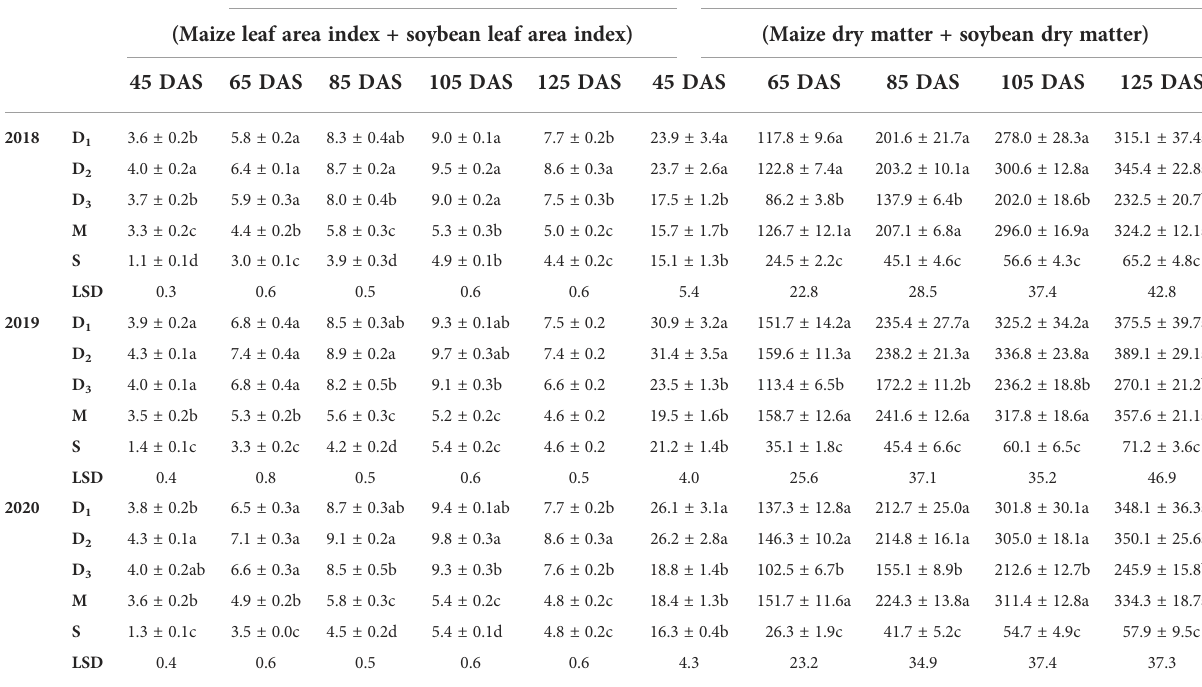
TABLE 3 Total leaf area index and total dry matter of maize and soybean at 45, 65, 85, 105, and 125 days after sowing (DAS) under different maize/soybean strip intercropping treatments and sole cropping of maize and soybean. Year Treatments Total leaf area index Total dry matter (g plant -1 ) (Maize leaf area index + soybean leaf area index) (Maize dry matter + soybean dry